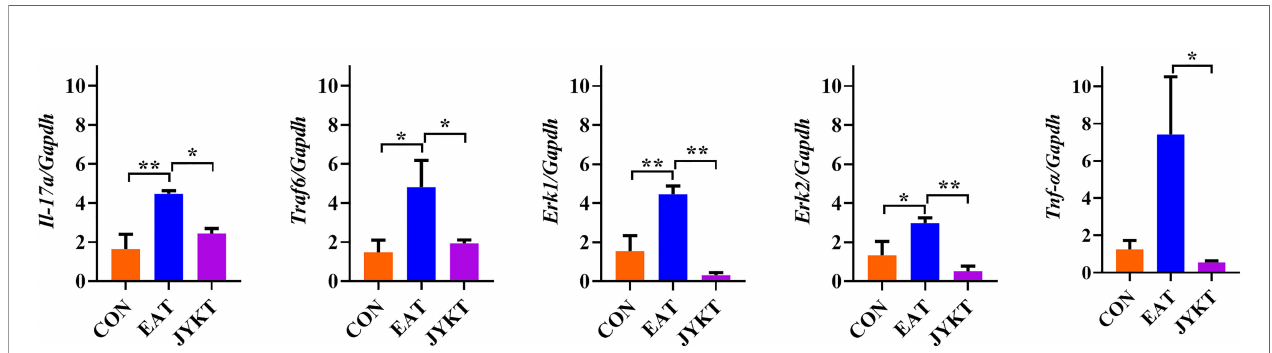
FIGURE 7 | Relative gene expressions of Il-17a, Traf6, Erk1, Erk2 and Tnf- a among groups. Data were shown as the relative expression ratio of targeted genes and Gapdh . * P < 0. 05, ** P < 0.